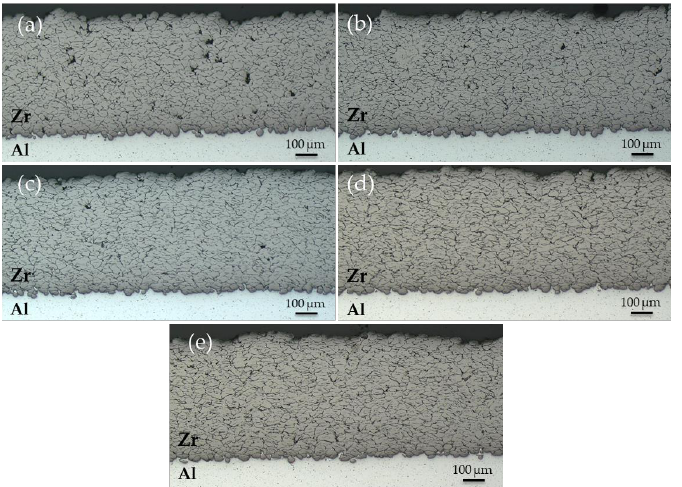
Figure 2. Optical micrographs of the polished and etched cross-section of samples ( a ) S1, ( b ) S2, ( c ) S3, ( d ) S4, and ( e ) S5.